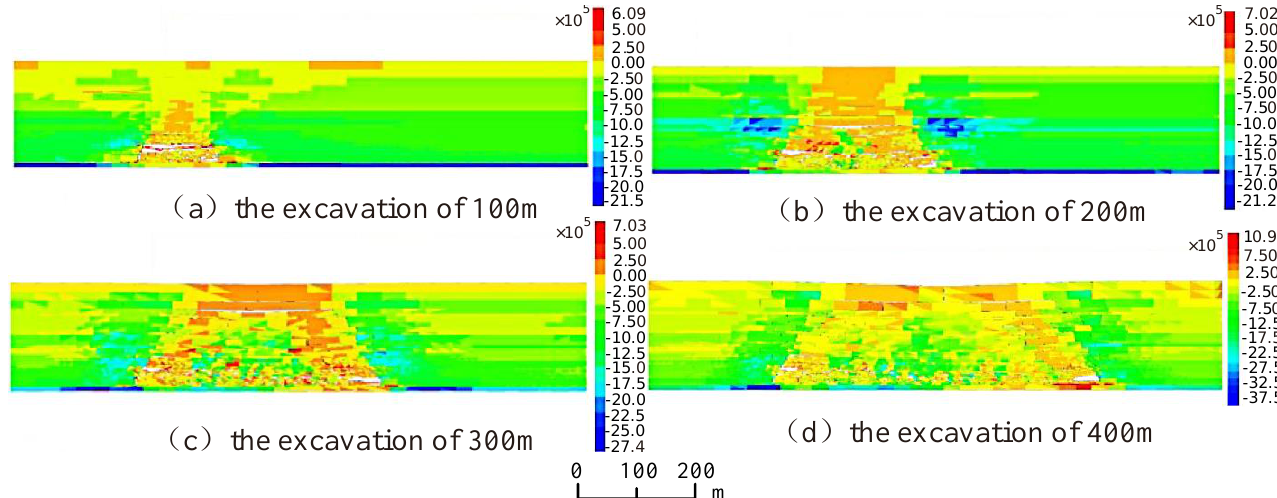
Figure 4. ( a – d ) describes the dynamic distribution of the maximum principal stress in overlying strata during different excavation periods of 100 m, 200 m, 300 m and 400 m.